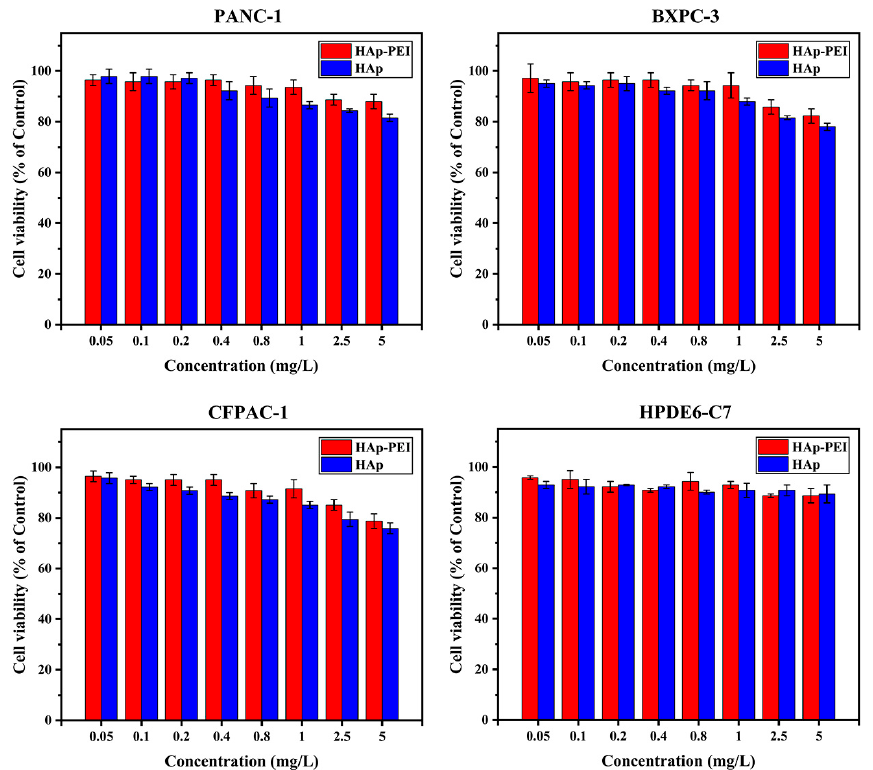
Figure 4. Cell viability of pancreatic cancer cells (PANC-1, BXPC-3, CFPAC-1) and pancreatic ductal epithe- lial cells (HPDE6-C7) co-incubated with HAp-PEI and HAp at various concentrations (0.05 mg/L–5 mg/L) for 48